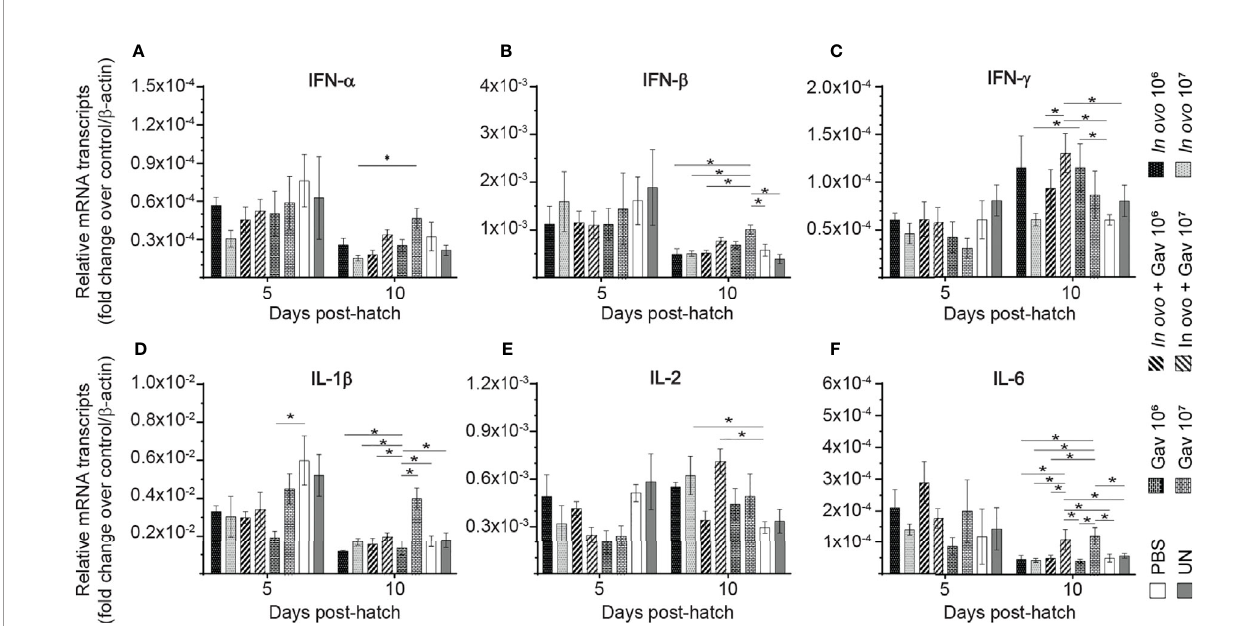
FIGURE 3 | Relative gene expression in the bursa of Fabricius of chickens inoculated with lactobacilli. The bursa of Fabricius samples were collected at days 5 and 10 post-hatch from all treatment groups: groups 1 and 2 received 10 6 and 10 7 CFUs of lactobacilli cocktail in ovo , respectively, at embryonic day eighteen; groups 3 and 4 received 10 6 and 10 7 CFUs of lactobacilli, respectively, via both in ovo and oral gavage (on days 1, 7, 14, 21, 28 post-hatch); groups 5 and 6 received 10 6 and 10 7 CFUs of lactobacilli, respectively, via oral gavage; group 7 was served as a negative control group and was injected with phosphate-buffered saline (PBS); group 8 remained untreated (UN). Fold change was used to characterize differences in gene expression of IFN- a , IFN- b , IFN- g , IL-1 b , IL-2, and IL-6 (A – F) , in comparison to negative control group. Statistical signi fi cance among treatment groups was calculated using SAS Proc GLM (General Linear Model) followed by Tukey ’ s comparison test. Error bars represent standard errors of the mean. Results were considered statistically signi fi cant if P < 0.05. Bars with asterisks represent a signi fi cant difference among treatments. The data are representative samples from 6 individual